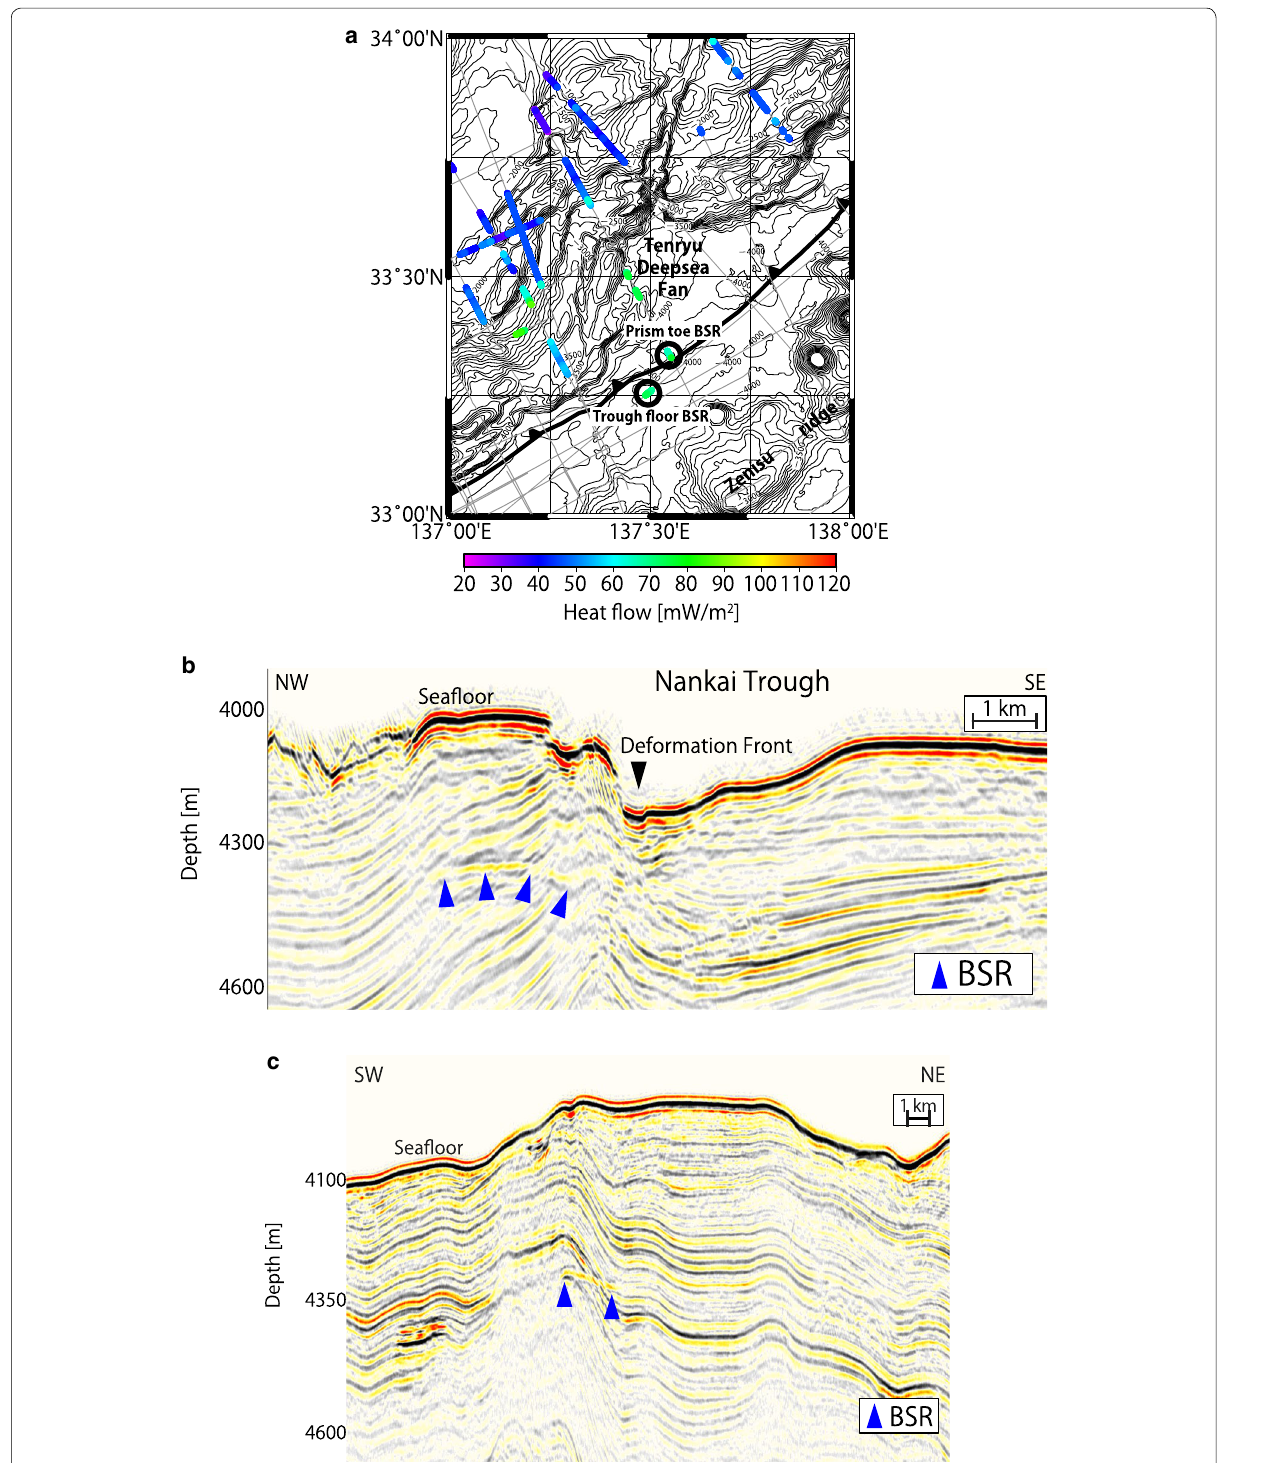
Fig. 6 Detected BSRs. a Map of BSR-derived heat flow in the Tokai area. BSRs were detected within the locations marked by the two black circles. Colored dots indicate heat flow values derived from the BSRs. b Seismic reflection image at the prism toe, where BSRs were found, shown with blue triangles. A P-wave velocity obtained from Site C0002 of the IODP Expeditions (Expedition 314 Scientists 2009) is used for time-to-depth conversion. c Seismic reflection image at the trough floor, where BSRs were found, shown with blue triangles. A P-wave velocity obtained from Site C0002 of the IODP Expeditions (Expedition 314 Scientists 2009) is used for time-to-depth